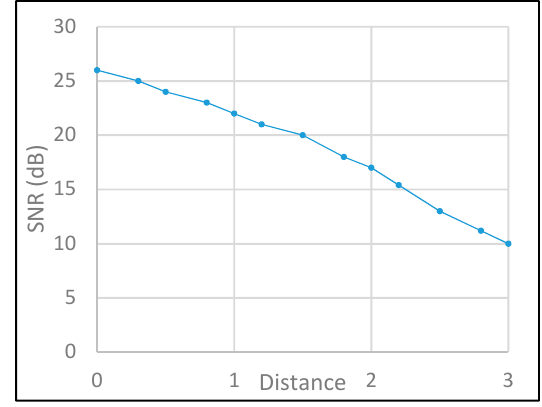
Figure 17. SNR evaluation. Sensors 2019 , 19 , x FOR PEER REVIEW